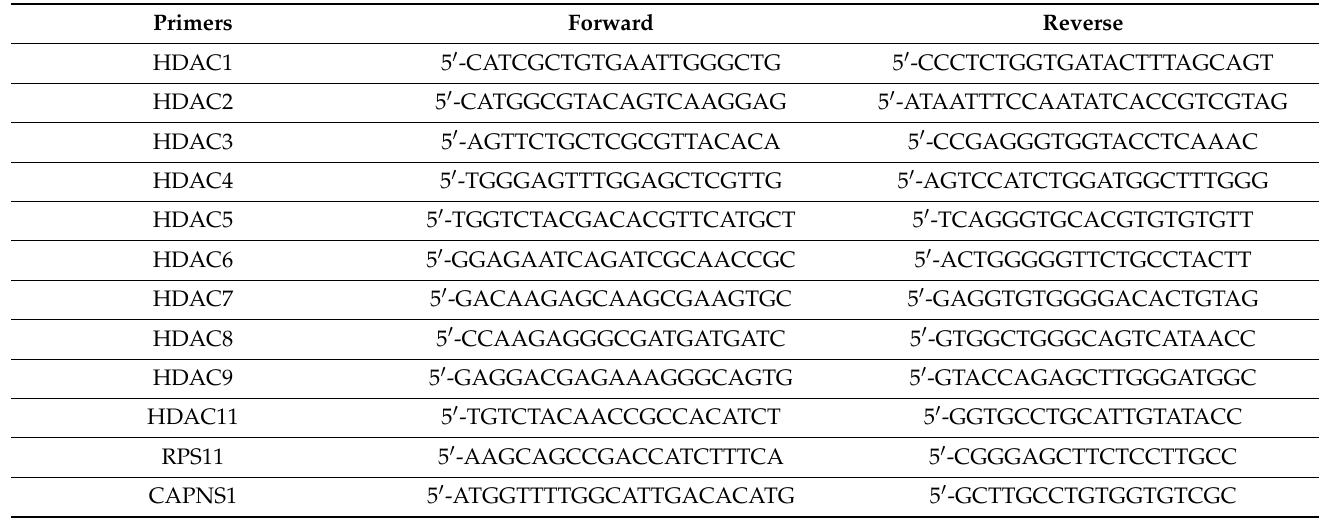
Table 1. Sequences of primers used in the qPCR